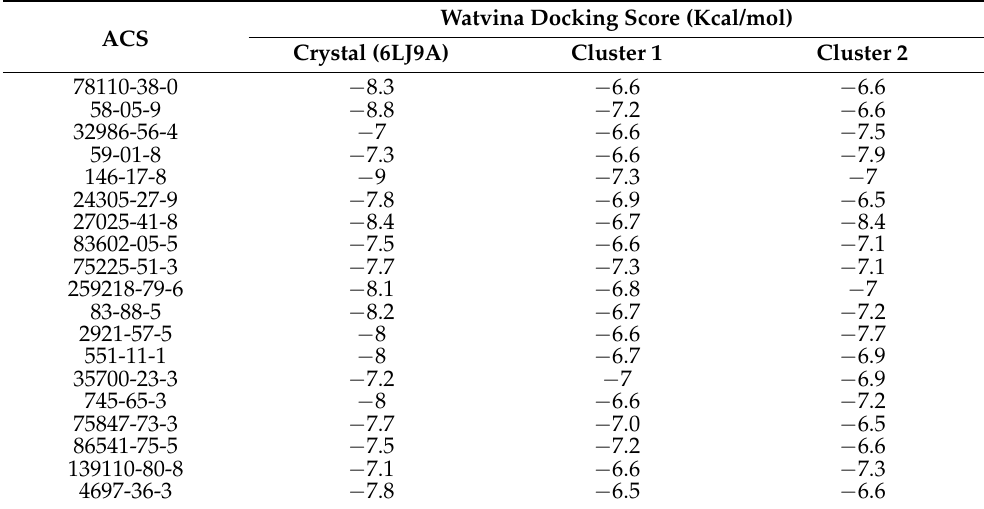
Table 1. Watvina docking scores of FDA-approved drugs with Crystal (6LJ9A), Cluster 1, and Cluster